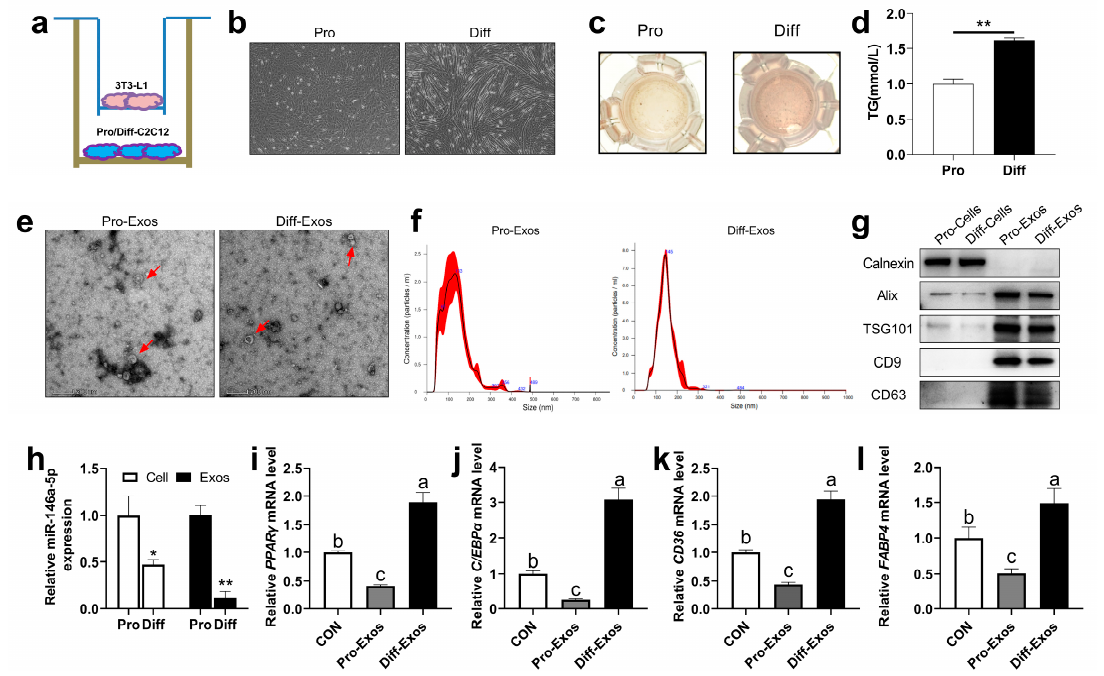
Figure 1. Effects of skeletal muscle-derived exosomes on adipogenesis in 3T3-L1 cells. ( a ) C2C12 cells were co-cultured with 3T3-L1 cells, and the cells were grown in a transwell. ( b ) The morphology of C2C12 cells before and after differentiation was observed under a microscope (scale bar = 100 µ m). ( c ) During co-culture, differentiated 3T3-L1 adipogenic precursor cells were induced to mature, and oil red O staining was performed. ( d ) During co-culture, the differentiation of 3T3-L1 adipocyte precursor cells was induced to mature to examine TG content (n = 6). ( e ) Electron microscopy photographs of C2C12 cells-derived exosomes proliferation (Pro-Exos) and differentiation (Diff- Exos) (scale bar = 200 nm). ( f ) Nanoparticle tracking analysis (NTA) was used to determine the size distribution and concentration of exosomes. ( g ) Marker proteins Alix, TSG101, CD9, and CD63 in exosomes extracted from C2C12 cells, and the Western Blot detection bands of endoplasmic reticu- lum marker protein Calnexin. ( h ) The expression of miR-146a-5p in C2C12 cells proliferation and differentiation (n = 6), and the expression of miR-146a-5p in C2C12 cells-derived exosomes of the proliferation and differentiation (n = 4). ( i – l ) After treatment with skeletal muscle-derived exosomes (Pro-Exos, Diff-Exos), adipogenesis-related genes PPAR γ and C/EBP α , and fatty acid synthesis-re- lated genes CD36 and FABP4, were detected by real-time quantitative PCR after induced differen- tiation in 3T3-L1 preadipocytes (n = 6). Values are presented as means ± SEM, * p < 0.05, and ** p < 0.01, according to the non-paired Student’s t -test or one-way ANOVA between individual groups. Different letters mean significant difference ( p < 0.05), and the same letters mean no significant dif- ference ( p > 0.05) .